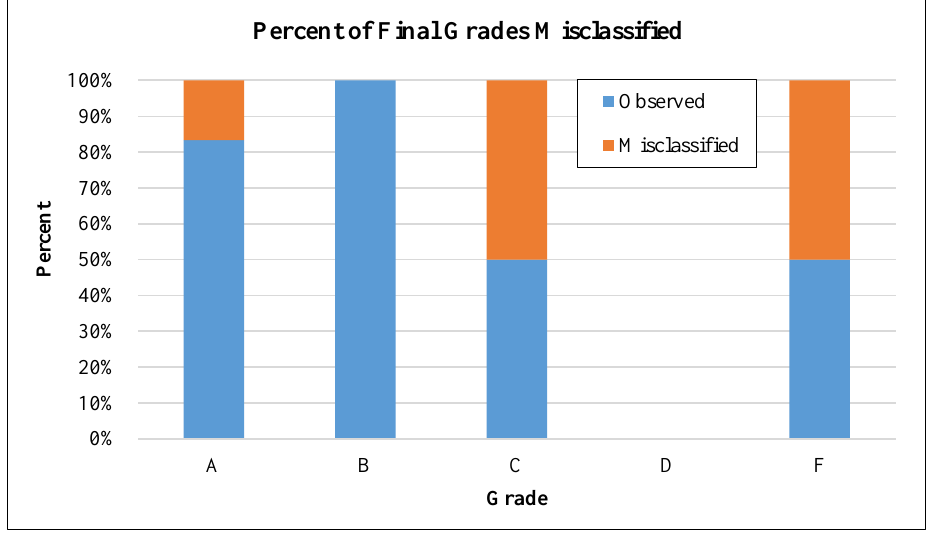
Figure 7. Percent of grades misclassified by SVM